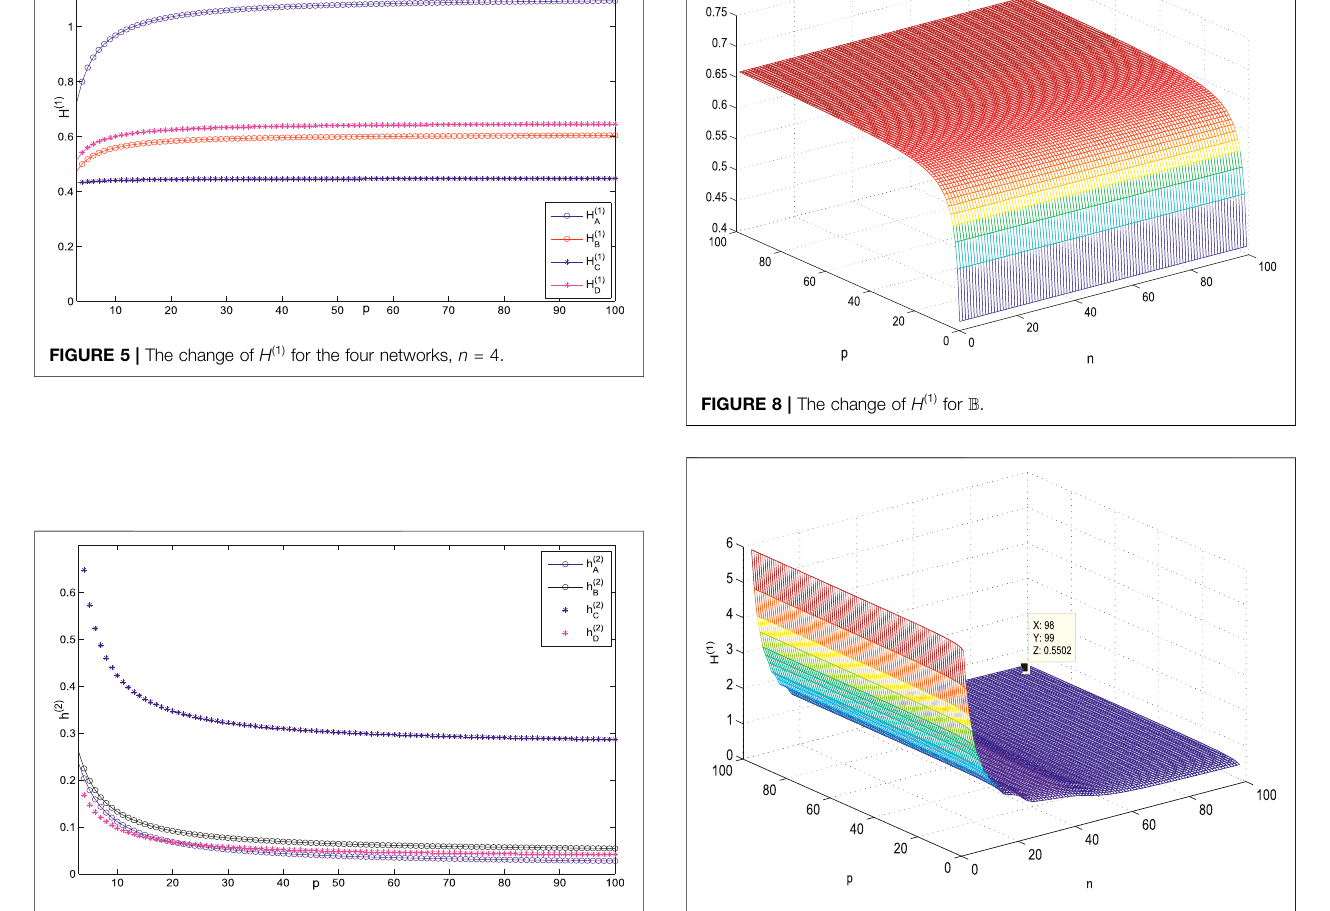
FIGURE 9 | The change of H (1) for C